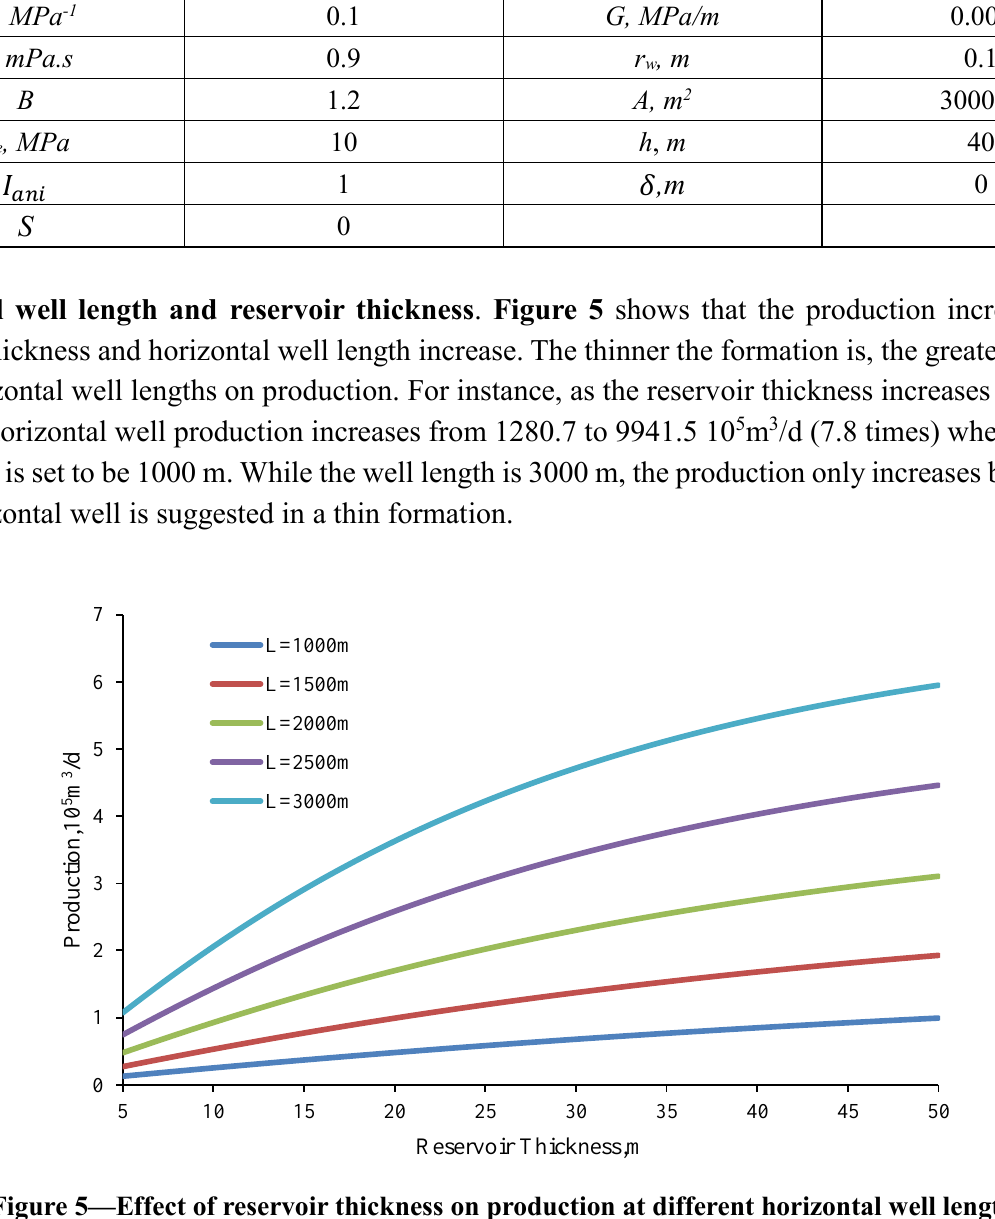
Figure 5—Effect of reservoir thickness on production at different horizontal well